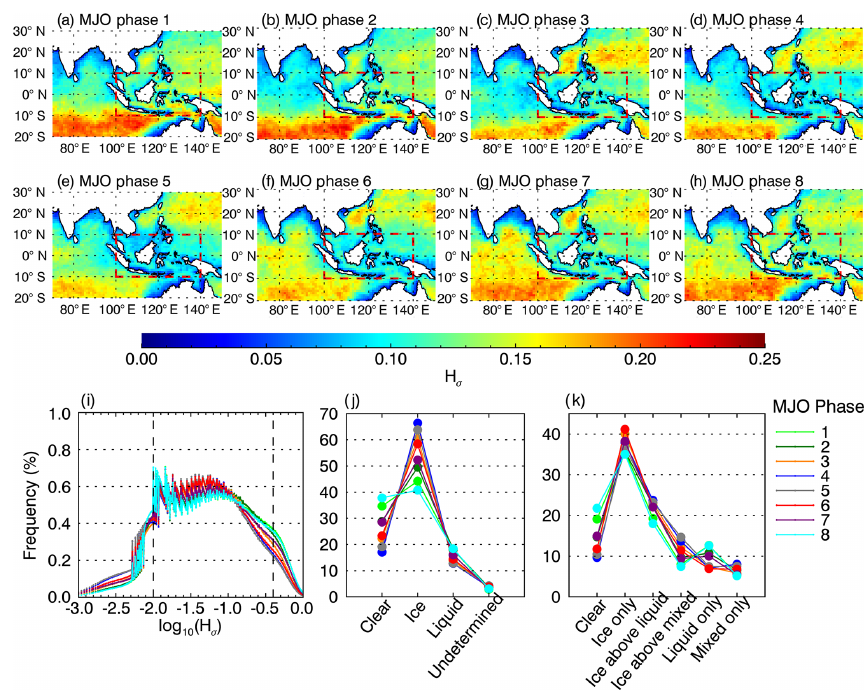
Figure 12. Cloud phase characteristics in different MJO phases: (a–h) spatial distributions of all-sky H σ derived from MYD06; (i) PDF of all-sky H σ derived from MYD06 over the Maritime Continent (the dashed red box in each panel); (j) occurrence frequency of clear sky and ice, liquid, and undetermined clouds from MYD06 (unit: %); panel (k) is the same as (j) but for clear sky and five groups derived from the 2B-CLDCLASS-LIDAR